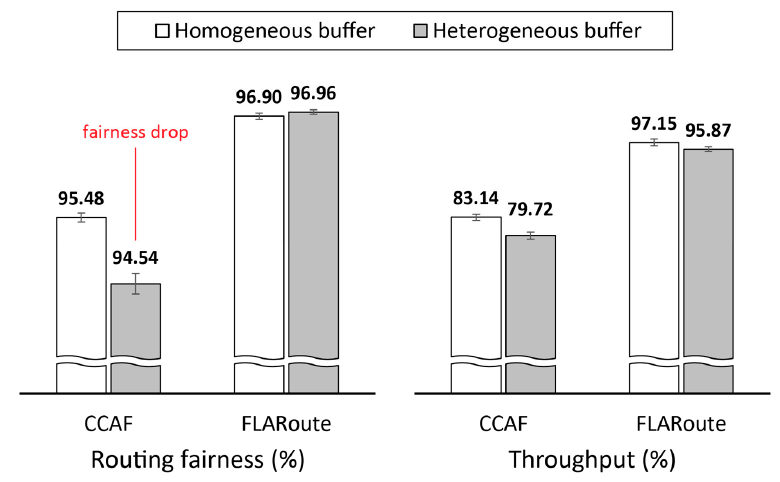
Figure 27. Routing fairness and throughput under homogeneous and heterogeneous buffer capacities.